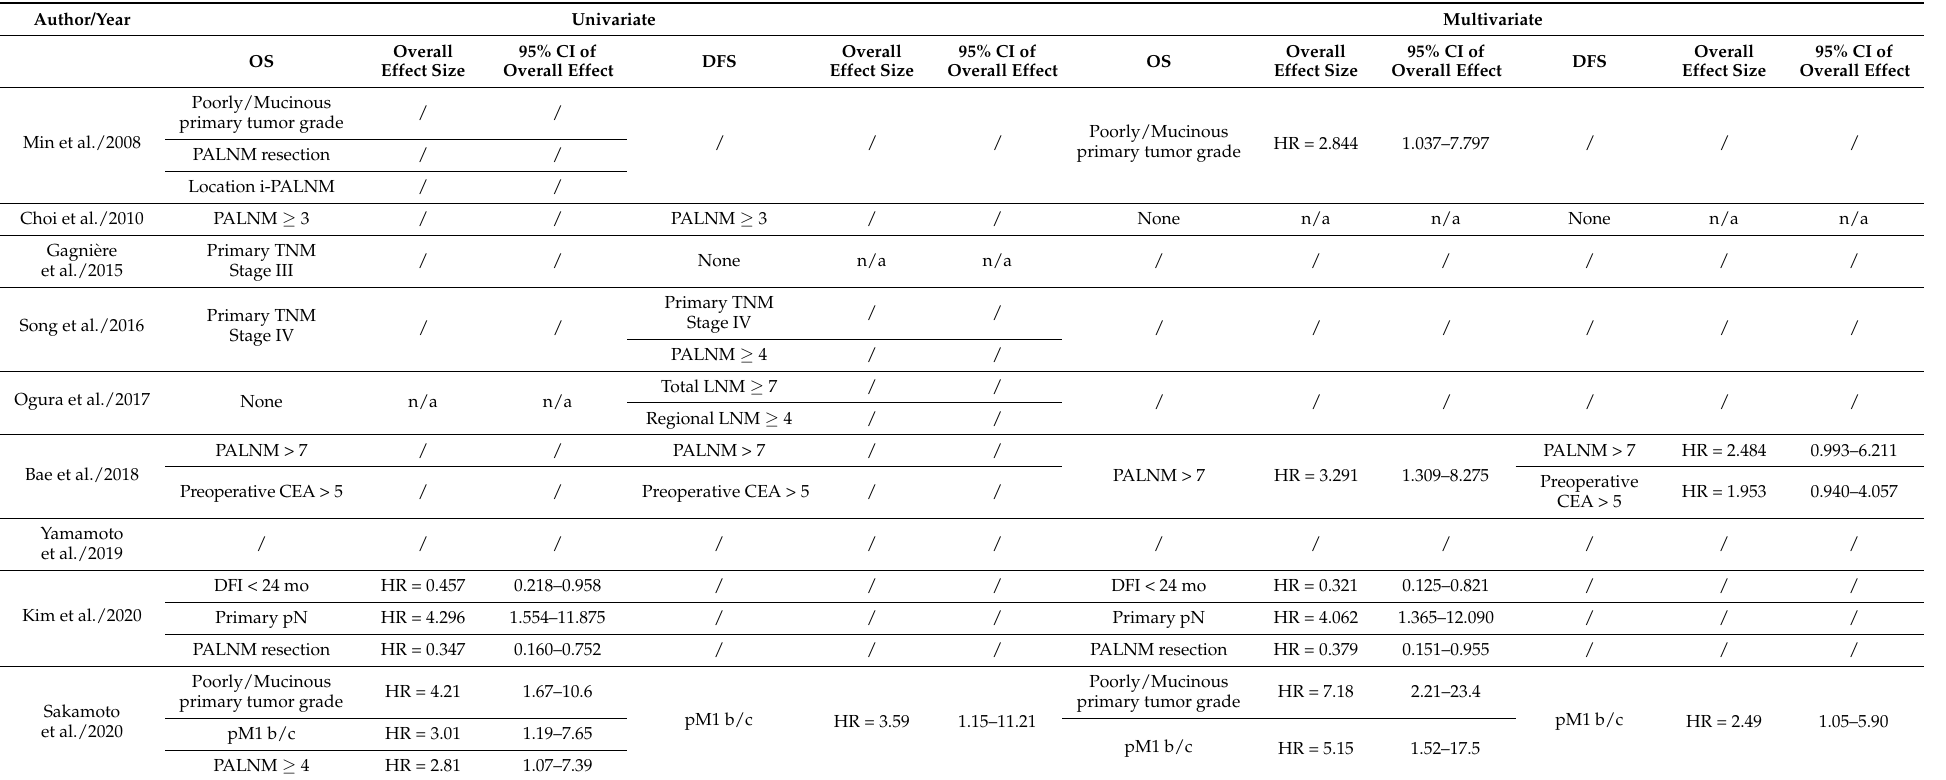
Table 5. Prognostic factors reported by